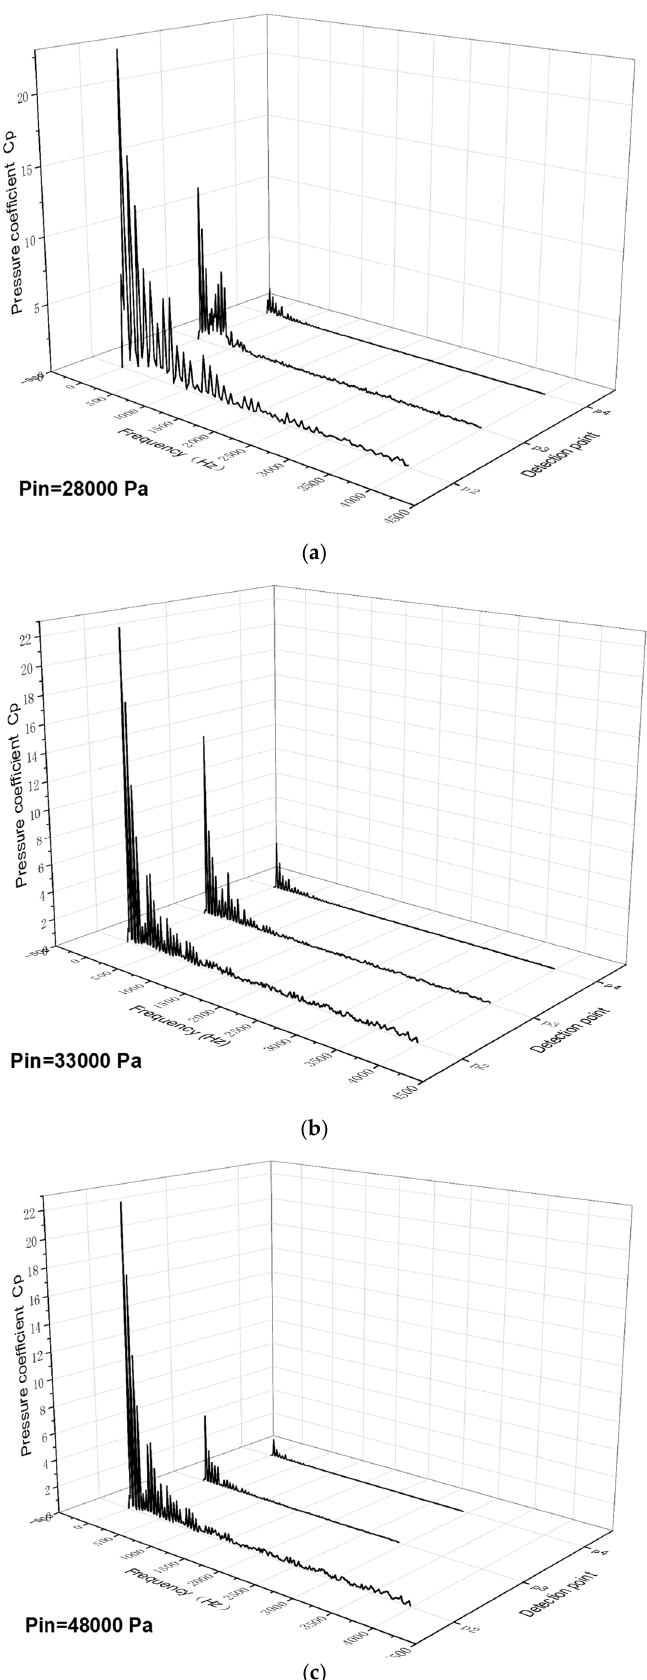
Figure 16. ( a – c ) Frequency-domain diagram of pressure pulsation at the suction surface of the